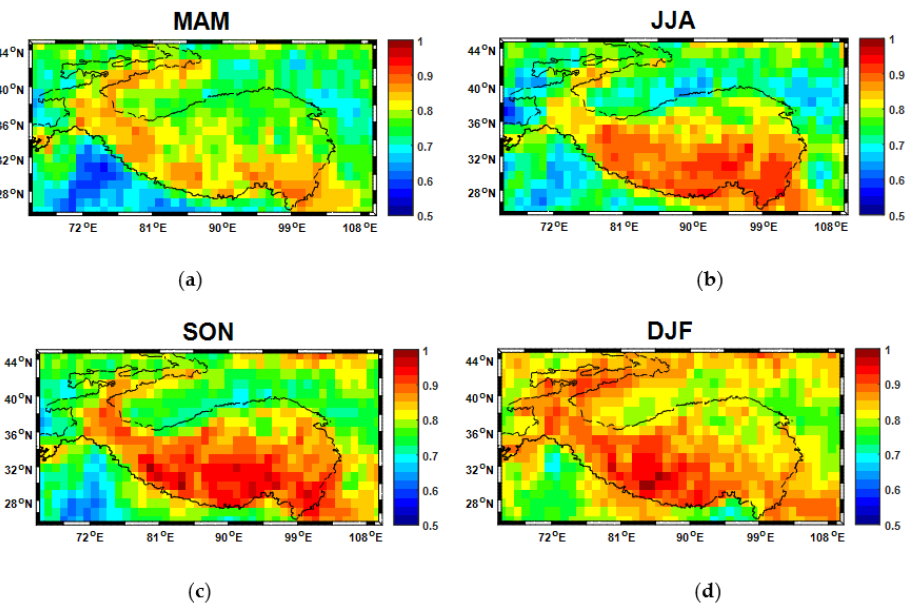
Figure 8. Seasonal maps of the proportion of the lowest aerosol layer AOD (PAOD 1 ) over the TP: ( a ) spring, ( b ) summer, ( c ) fall, and ( d ) winter over the eight-year data period from January 2007 to December 2014 (The AOD is at 532 nm and the map is gridded at 1°).